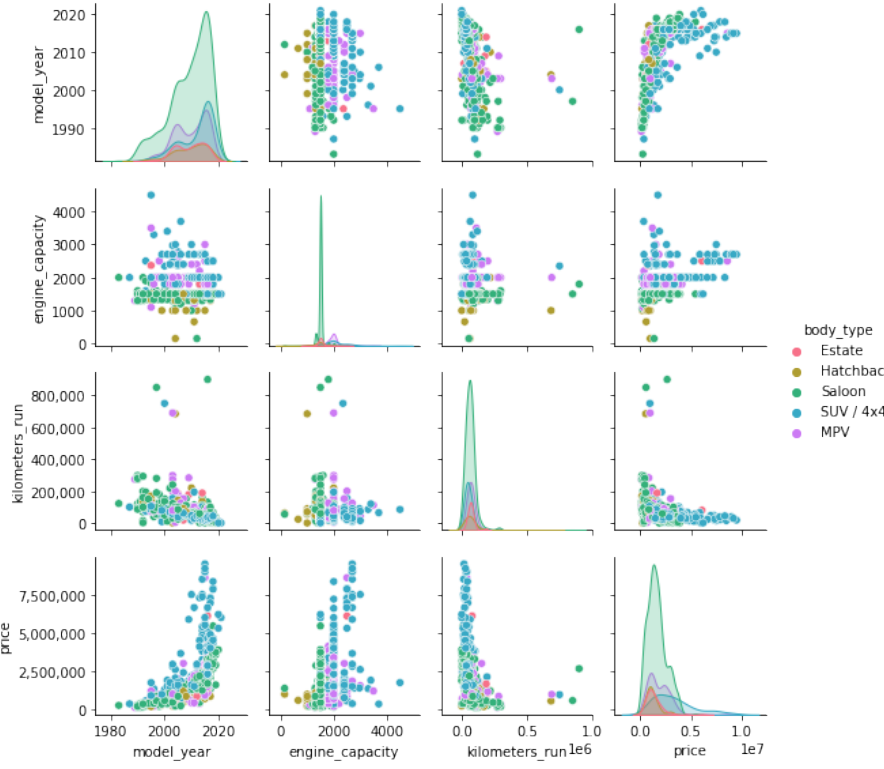
Figure 10. Pair plot of cars of different body_type .